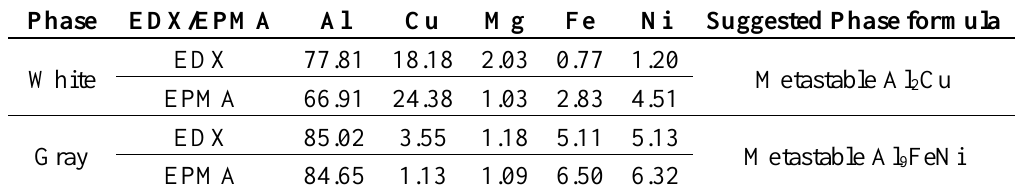
Table 5. The compositions of intermetallic compounds in Sample WC measured by EDX and EPMA